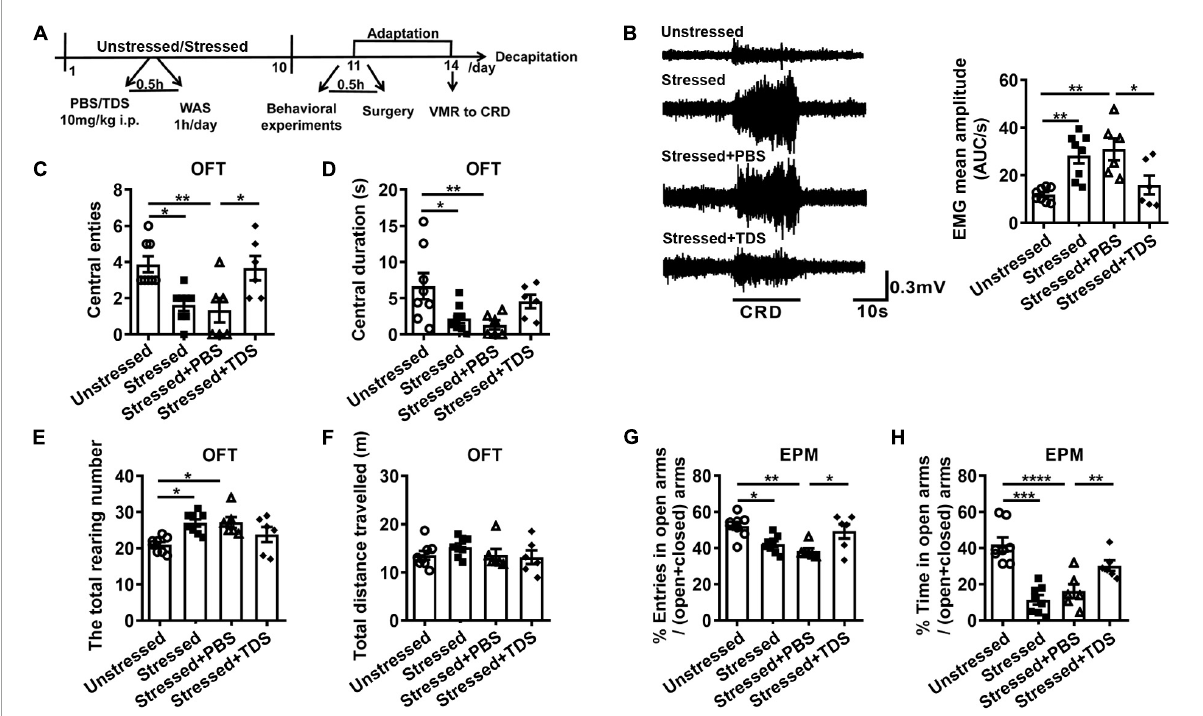
FIGURE1 Tandospirone (TDS) ameliorated visceral hypersensitivity and anxiety-like behavior in stressed rats. (A) Experimental design. (B) The representative EMG of visceromotor response to 60 mmHg CRD (left) and the mean amplitude of EMG (right). Analysis of the number of central entries (C) , central duration (D) , the total raring number (E) , the total distance travelled (F) in the open field test (OFT). Analysis of the percentage of a number of open arms entries (G) and the percentage of time spent into open arms (H) in the elevated plus maze (EPM) test. Unstressed: n = 8, Stressed: n = 8, Stressed + PBS: n = 6, Stressed + TDS: n = 6, * p < 0.05, ** p < 0.01, *** p < 0.001, **** p < 0.0001. Data are presented as means ±